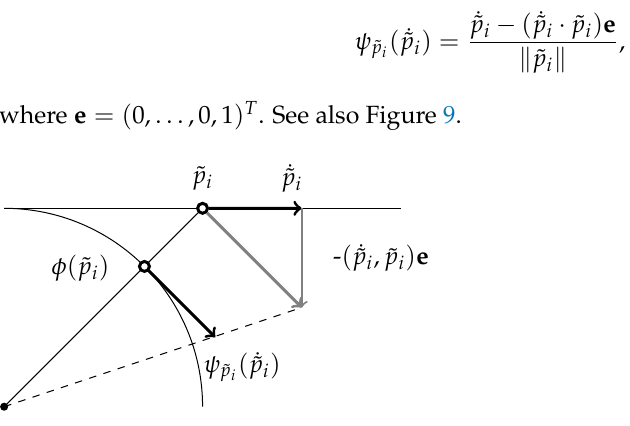
Figure 9. Transfer of infinitesimal motions between A d and S d